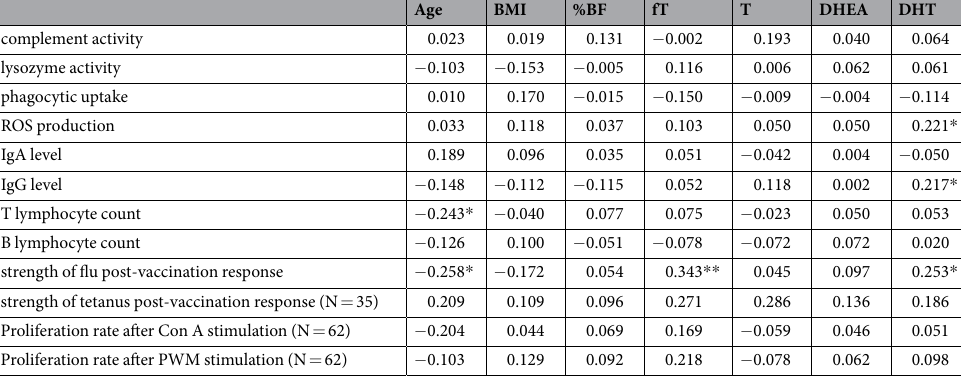
Table 2. Correlations between immune function parameters and participants’ age, adiposity, and hormone levels. * p < 0.05; ** p <